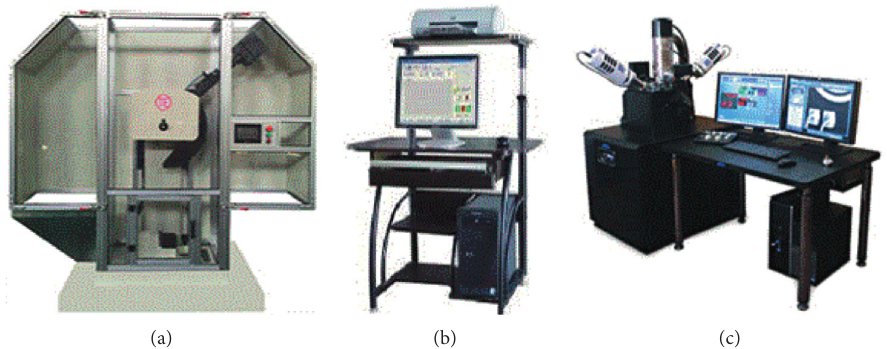
Figure 7: (a) Izod impact machine; (b) computer integrated to impact testing machine; (c)